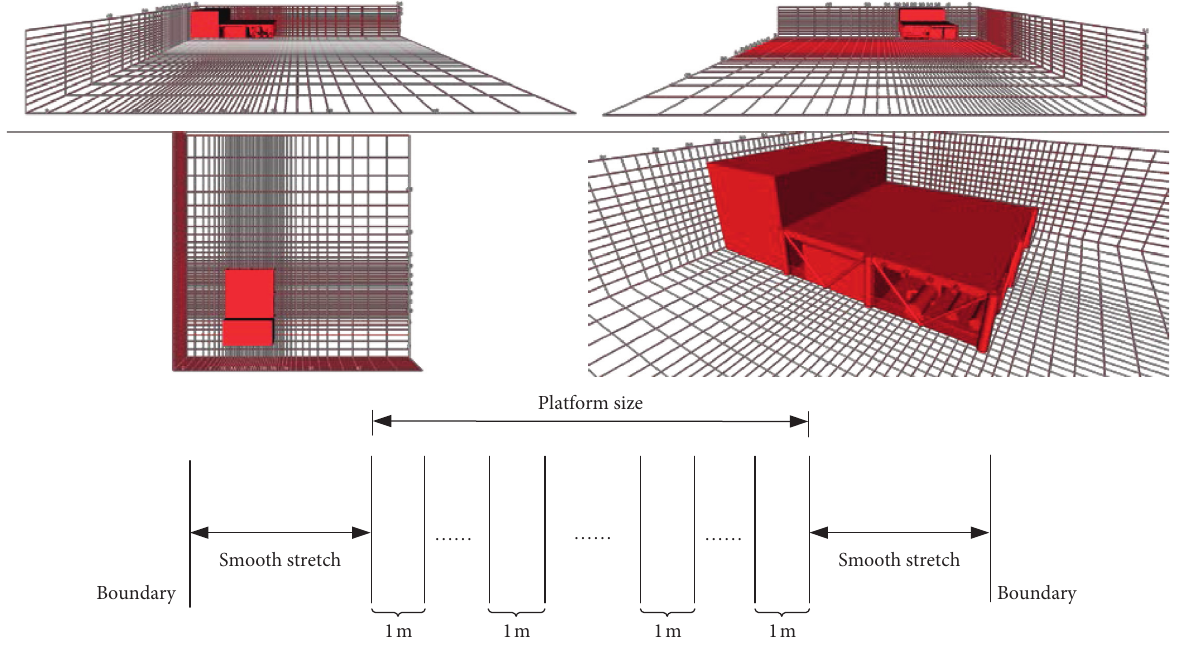
Figure 26: Typical grid solution for explosion models. Table 6: Main explosion parameter sets.